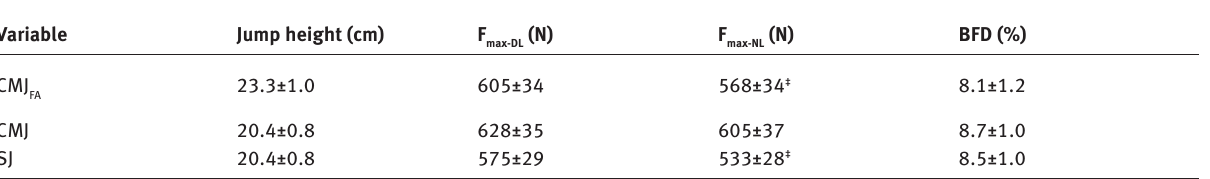
Table 4: Jump tests scores for dominant and non-dominant limbs.